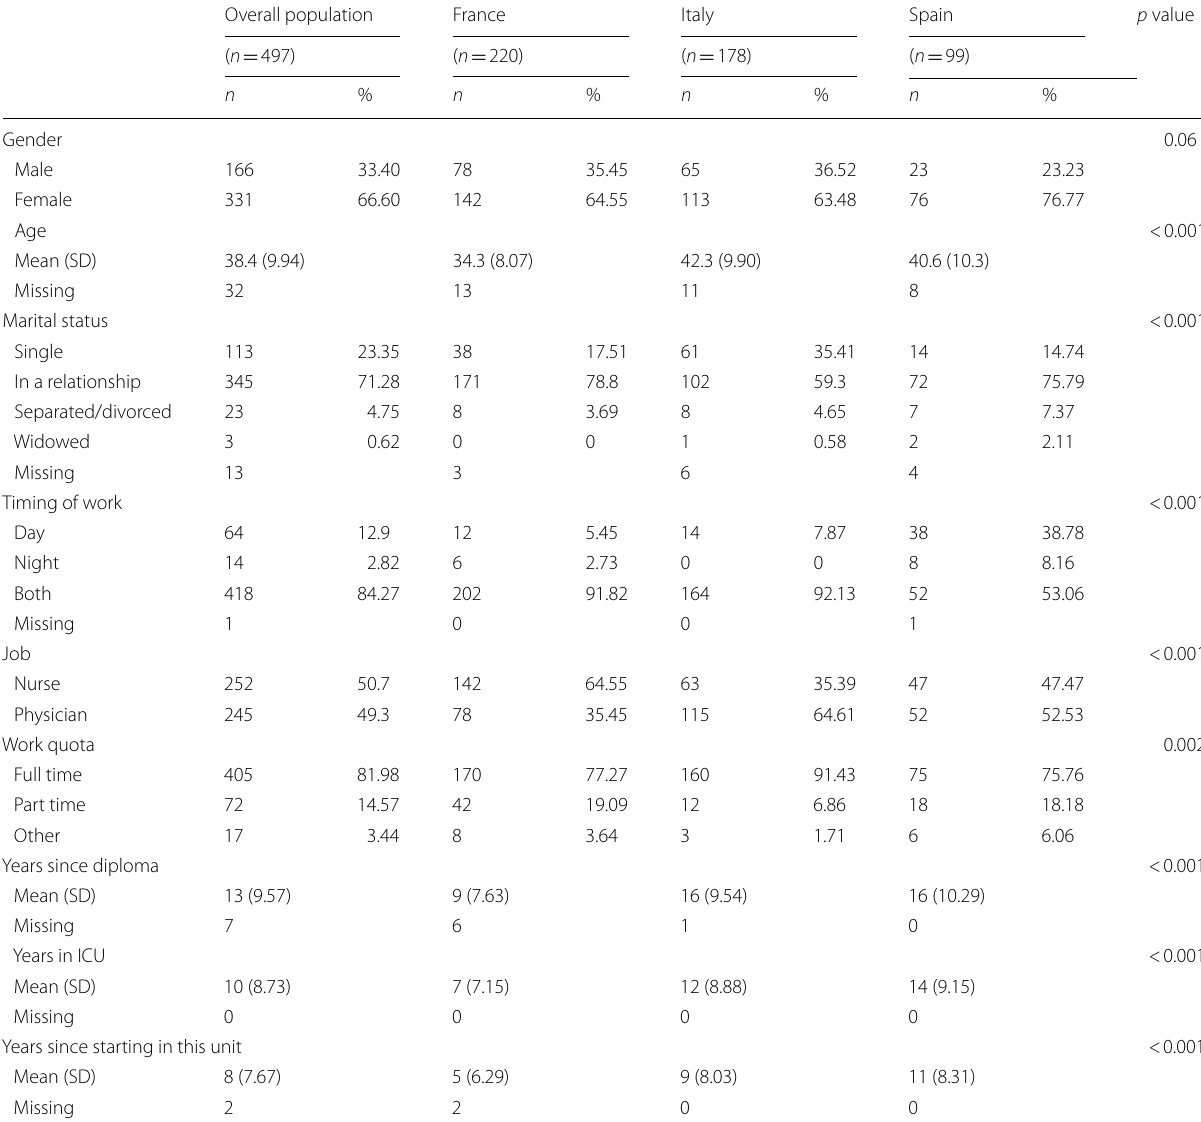
Table 3 General characteristics of the participants in the Phase 3 validation study